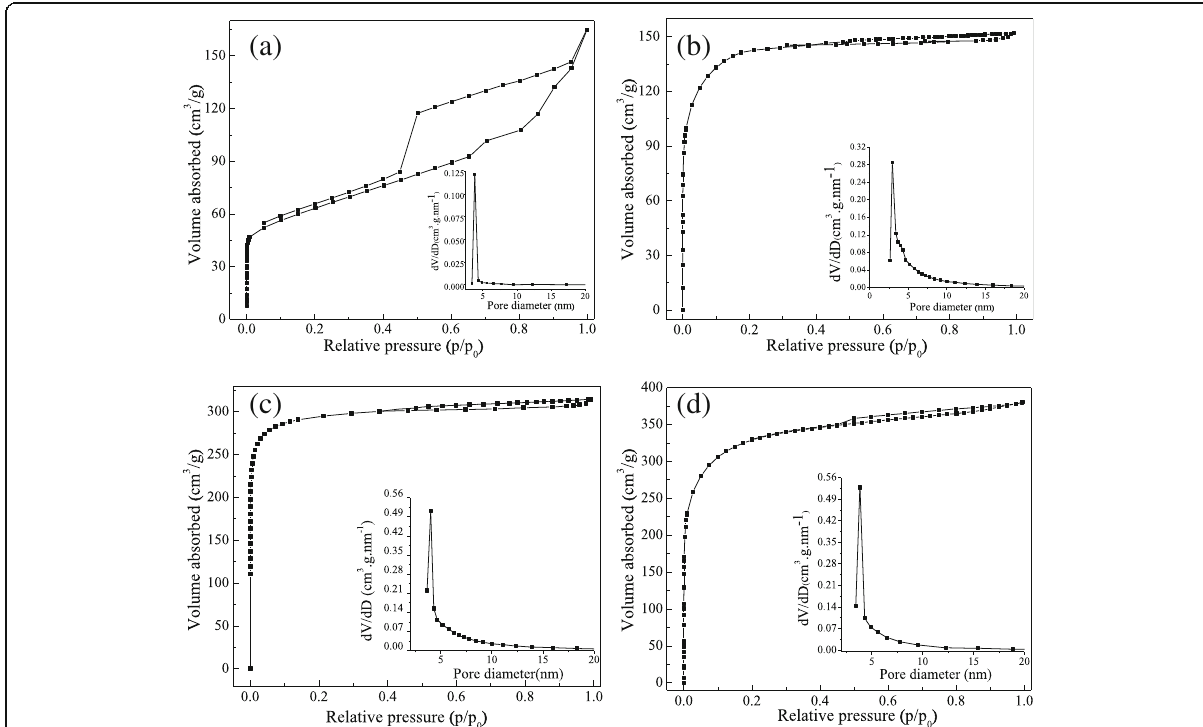
Fig. 3 Nitrogen adsorption – desorption isotherms and the pore size distributions of MCMs. a MCMs without ZnCl 2 impregnation. b MCMs calcined at 550 °C for 1 h without ZnCl 2 impregnation. c MCMs with ZnCl 2 impregnation for 1 h were calcined at 550 °C for 1 h. d MCMs with ZnCl 2 impregnation for 1 h were calcined at 600 °C for 1 h